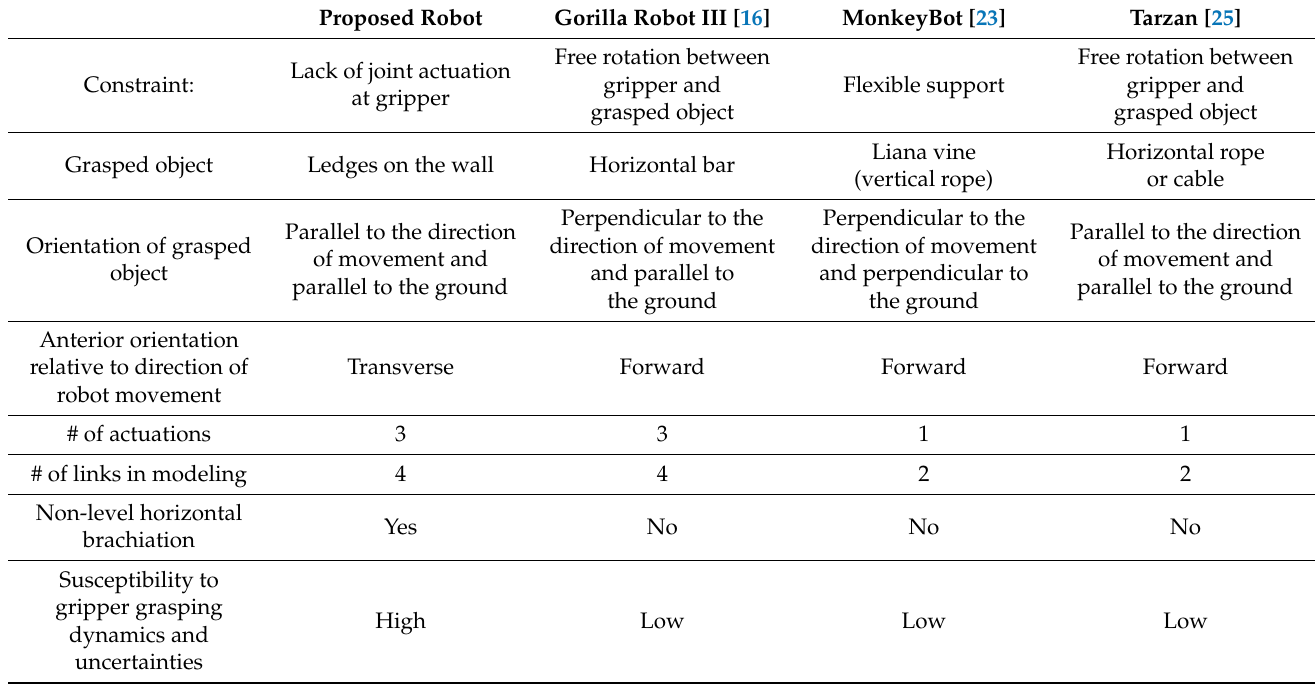
Table 1. Comparison of brachiation robots and associated movement